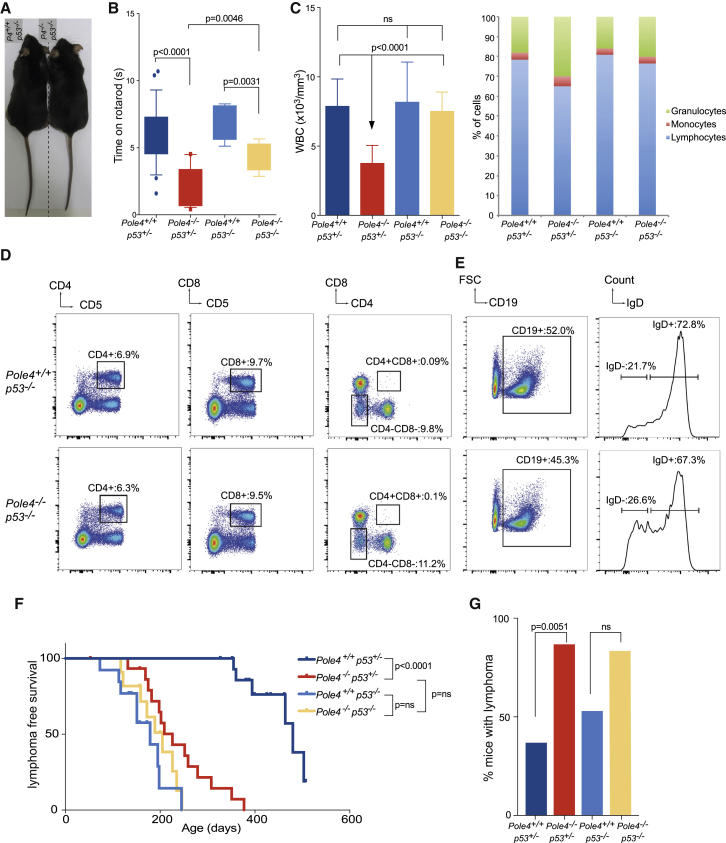
p53 Deficiency Rescues Embryonic Lethality and Drive Tumorigenesis in Pole4−/− Mice(A) Representative picture of Pole4/p53 mice. Note the similar size between Pole4+/+p53−/− and Pole4−/−p53−/− animals.(B) Rotarod experiment testing Pole4+/+ and Pole4−/− mice coordination in a p53+/− or p53−/− background. Note the decreased time spent on the rotating rod by Pole4−/−p53+/− mice compared to their control littermates. Error bars represent ± SEM of n = 27 Pole4+/+p53+/−, n = 18 Pole4−/−p53+/−, n = 6 Pole4+/+p53−/−, n = 6 Pole4−/−p53−/−. Significance: t test; Pole4+/+p53+/− versus Pole4−/−p53+/−, p < 0.0001; Pole4−/−p53+/− versus Pole4+/+p53−/−, p < 0.0001; Pole4−/−p53+/− versus Pole4−/−p53−/−, p = 0.0046; Pole4+/+p53+/− versus Pole4−/−p53−/−, p = 0.0031; Pole4+/+p53+/− versus Pole4+/+p53+/−, p < 0.0001.(C) Hematology analysis of Pole4/p53 mice. White blood cell count (left) and distribution (right). n = 24 Pole4+/+p53+/−, n = 21 Pole4−/−p53+/−, n = 8 Pole4+/+p53−/−, n = 11 Pole4−/−p53−/−. Significance: t test; Pole4+/+p53+/− and Pole4−/−p53−/− versus Pole4−/−p53+/−, p < 0.0001; Pole4+/+p53+/− versus Pole4−/−p53−/−, p = 0.633 and Pole4+/+p53+/− versus Pole4−/−p53+/−, p = 0.4245. Note the normal distribution of myeloid population in double mutant compared to Pole4−/−p53+/− animals.(D) Representative flow cytometry plots of Pole4/p53 mice spleen gated on T lymphocytes and demonstrating a similar number CD4+ and CD8+ single-positive cells and CD4−CD8− double-negative population. At least three animals have been analyzed per condition, and analyses were done in triplicates. CD5 was used as T cell marker.(E) Representative flow cytometry plots of Pole4/p53 mice spleen gated on B lymphocytes and demonstrating a similar number CD19+ and IgD− cells. At least three animals have been analyzed per condition, and analyses were done in triplicates.(F) Lymphoma-free survival of Pole4/p53 mice. n = 16 Pole4+/+p53+/−, n = 16 Pole4−/−p53+/−, n = 13 Pole4+/+p53−/−, n = 11 Pole4−/−p53−/−. Significance: Mantel-Cox test; Pole4+/+p53+/−versus Pole4−/−p53+/−, p < 0.0001; Pole4+/+p53−/− versus Pole4−/−p53−/−, p = 0.3066; Pole4−/−p53+/− versus Pole4−/−p53−/−, p = 0.0746. Mice culled due to nonspecific phenotypes (e.g., dermatitis, overgrown teeth, and fits) were excluded from this study.(G) Lymphoma frequency of Pole4/p53 mice. Significance: Fisher’s exact test; Pole4+/+p53+/− versus Pole4−/−p53+/−, p = 0.0051; Pole4+/+p53−/− versus Pole4−/−p53−/−, p = 0.1261.